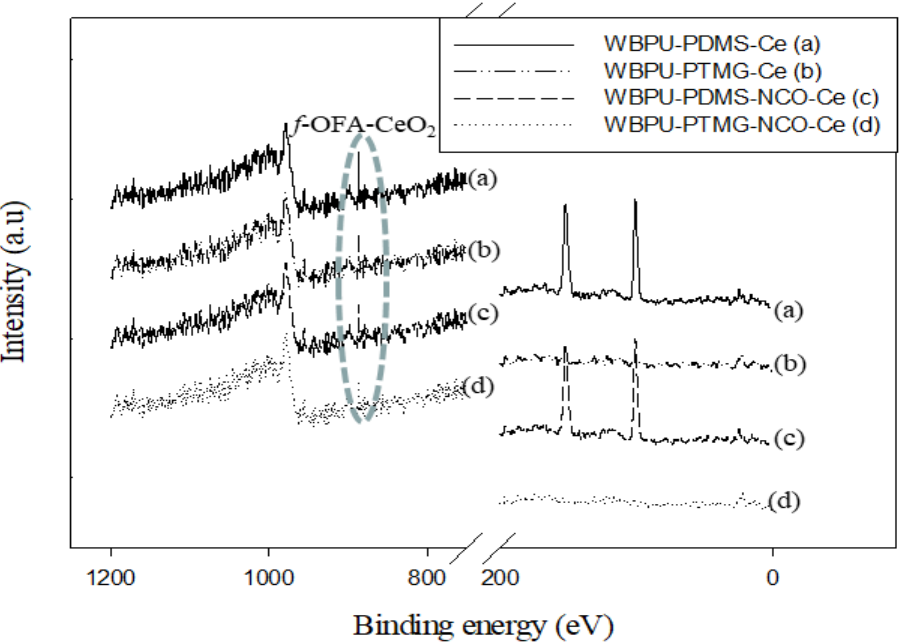
Figure 5. XPS scan of top surface of typical coatings.